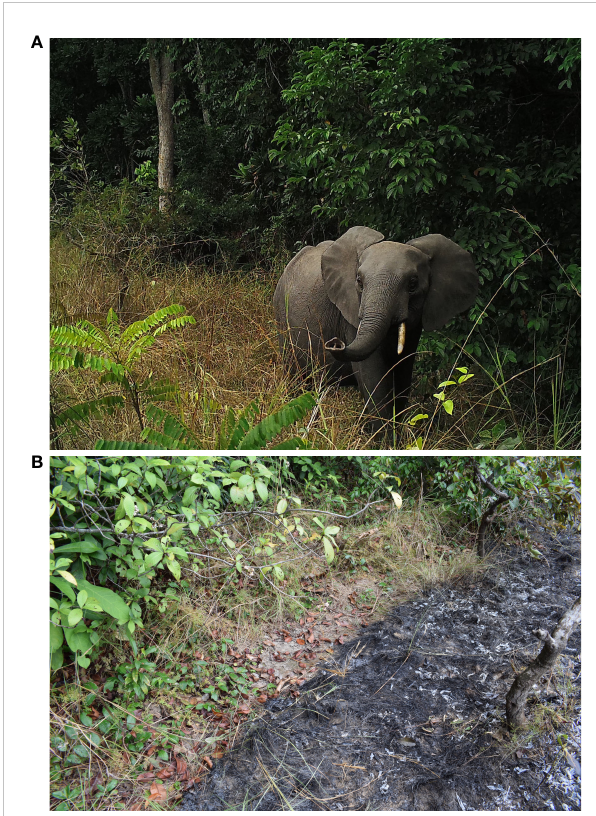
FIGURE 4 Showing how repeated travel along a path at the forest edge by forest elephants ( Loxodonta cyclotis ) (A) in Lope ́ National Park, Gabon, leads to the creation of a fi rebreak (B) that prevents savanna fi res from burning into the forest interior. (Photos: A. W. Cardoso).